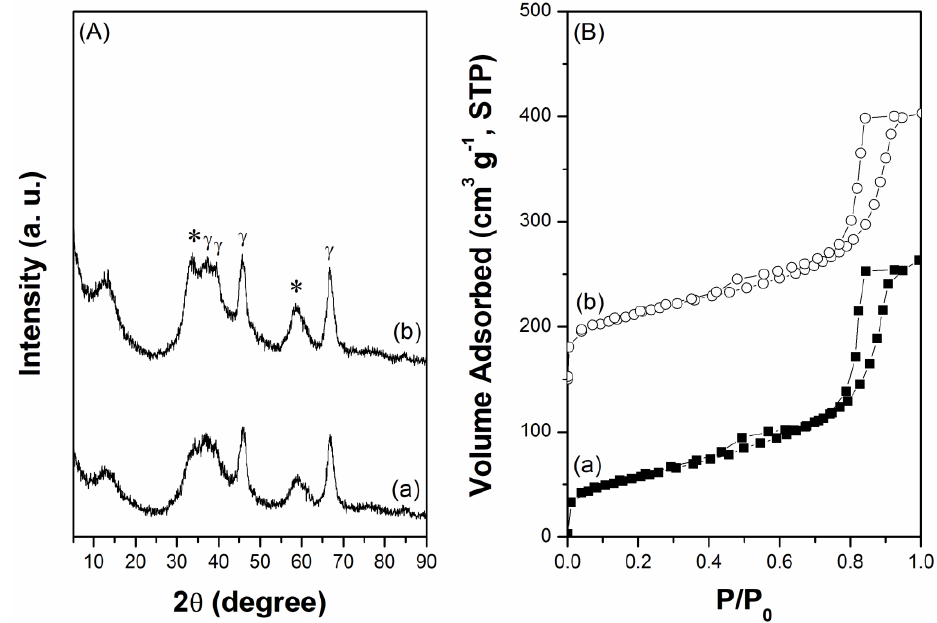
Figure 1. ( A ) Wide-angle XRD patterns and ( B ) N 2 adsorption-desorption isotherms of mesoporous sulfide catalysts (a) CoMo/γ-Al 2 O 3 and (b) NiMo/γ-Al 2 O 3 . The asterisk and gamma (γ) represent the MoS 2 -like slabs and γ -Al 2 O 3 phase, respectively.